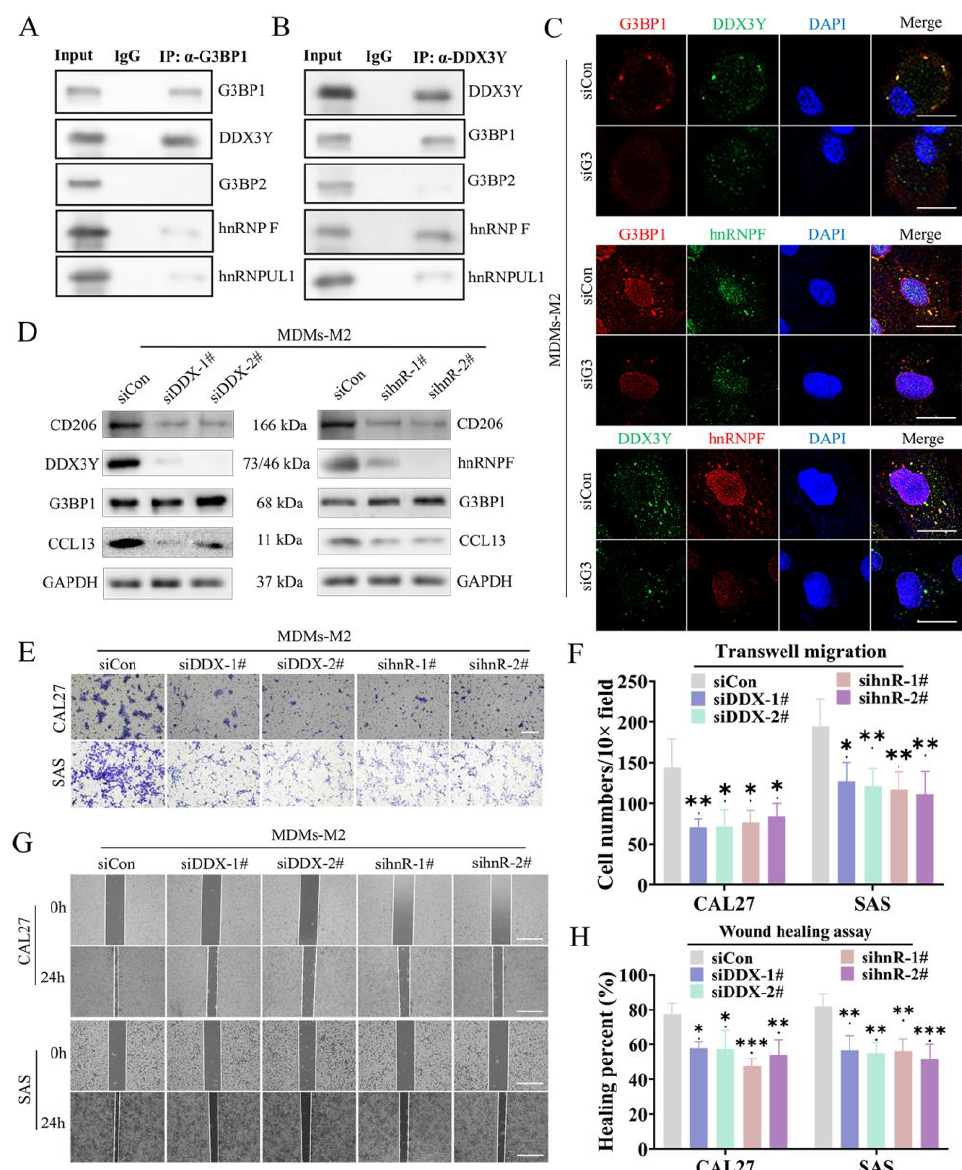
Figure 4. SG regulated the interaction between G3BP1 and DDX3Y-hnRNPF and the expression of CCL13. ( A , B ) The lysates from MDMs-M2 were performed to coimmunoprecipitation using rabbit isotype IgG or G3BP1 and DDX3Y antibody. ( C ) The representative immunostaining images of G3BP1 and DDX3Y or hnRNPF were performed by IF in MDMs-M2 transfected with control or G3BP1 siRNA. Scale bar, 10 μm. ( D ) Immunoblotting analyzed the protein expression of CCL13 and CD206 in MDMs-M2 transfected with control or DDX3Y and hnRNPF siRNA. ( E , F ) Transwell assays of CAL27 and SAS cells co-cultured with MDMs-M2 transfected with control siRNA or DDX3Y and hnRNPF siRNA. Scale bar, 50 μm. ( G , H ) Wound healing assays of CAL27 and SAS cells treated by conditioned medium from MDMs-M2 transfected with control siRNA or DDX3Y and hnRNPF siRNA. Scale bar, 100 μm. All data were derived from three independent experiments. (*, p < 0.05; **, p < 0.01 and ***, p < 0.001).